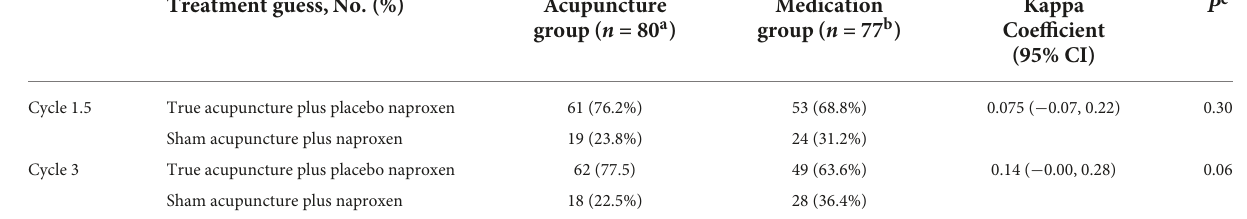
TABLE 4 Credibility of